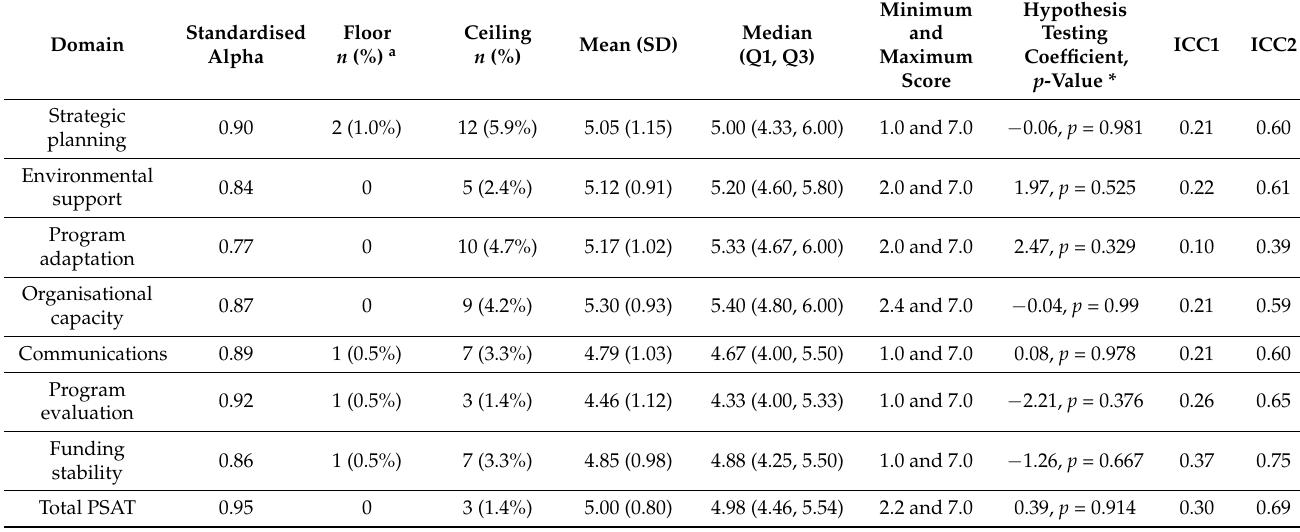
Table 4. Domain-level results assessing the internal reliability, floor and ceiling effects, norms, hypothesis testing and interrater